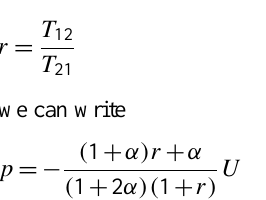
Table 2. Intensity of forces F 1 and F 2 at the singular points of a limit